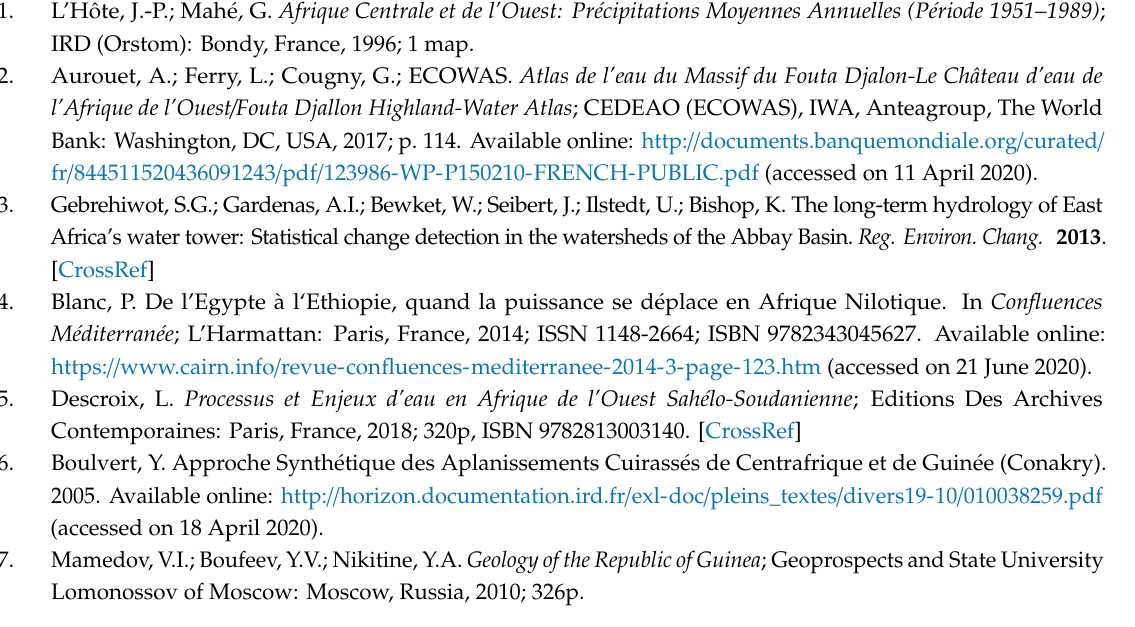
River basin. Figure S8a: Evolution of depletion coe ffi cient, Gambia River basin. Figure S8b: Evolution of rainfall and runo ff coe ffi cient, Gambia River basin. Figure S9a: Evolution of depletion coe ffi cient, Faleme River basin. Figure S9b: Evolution of rainfall and runo ff coe ffi cient, Faleme River basin. Figure S10a: Evolution of depletion coe ffi cient, Upper Bafing River basin. Figure S10b: Evolution of rainfall and runo ff coe ffi cient, Upper Bafing River basin. Figure S11a: Evolution of depletion coe ffi cient, Bafing River basin Figure S11b: Evolution of rainfall and runo ff coe ffi cient, Bafing River basin. Figure S12a: Evolution of depletion coe ffi cient, Upper Tinkisso River basin. Figure S12b: Evolution of rainfall and runo ff coe ffi cient, Upper Tinkisso River basin. Figure S13a: Evolution of depletion coe ffi cient, Tinkisso River basin. Figure S13b: Evolution of rainfall and runo ff coe ffi cient, Tinkisso River basin. Figure S14a: Evolution of depletion coe ffi cient, Upper Niger River basin. Figure S14b: Evolution of rainfall and runo ff coe ffi cient, Upper Niger River basin. Figure S15a: Evolution of depletion coe ffi cient, Niandan River basin. Figure S15b: Evolution of rainfall and runo ff coe ffi cient, Niandan River basin. Figure S16a: Evolution of depletion coe ffi cient, Milo River basin. Figure S16b: Evolution of rainfall and runo ff coe ffi cient, Milo River